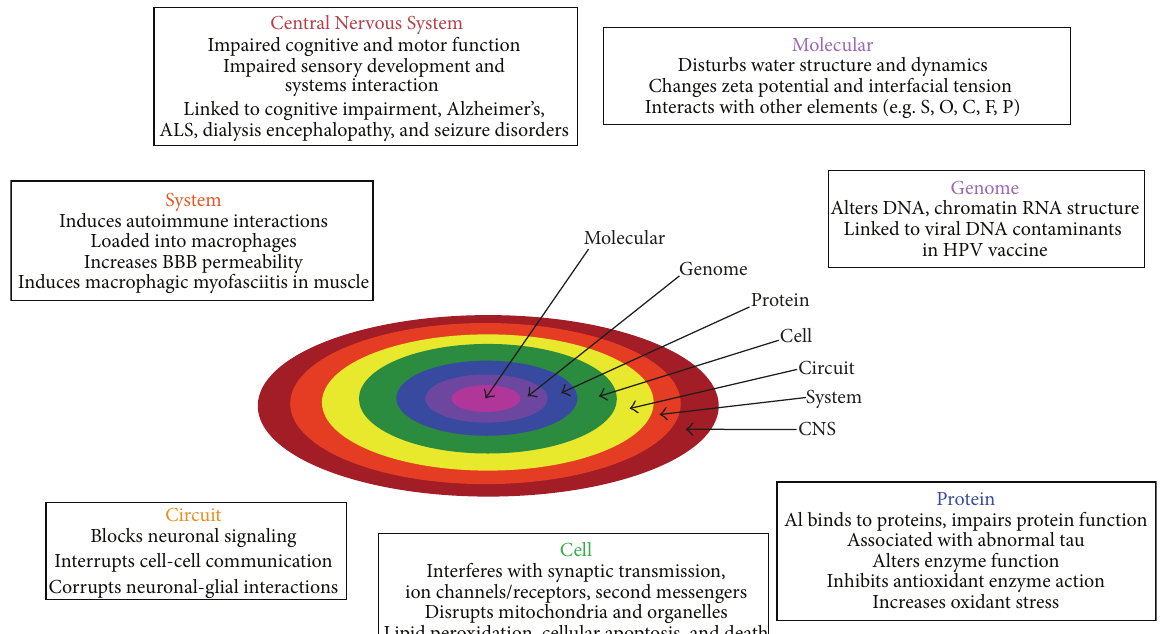
Figure 4: Schematic of the biosemiotic levels at which Al can impact the body and